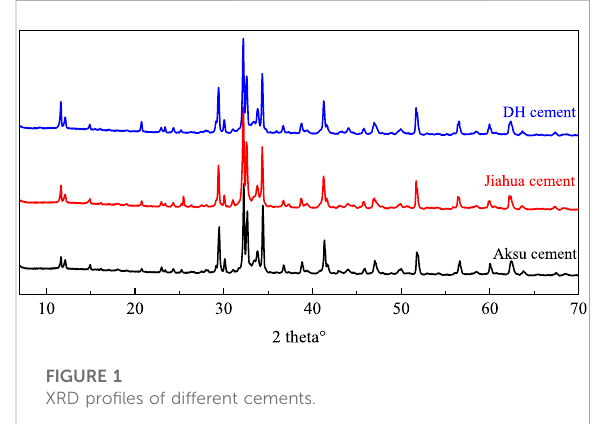
FIGURE 1 XRD pro fi les of different cements.